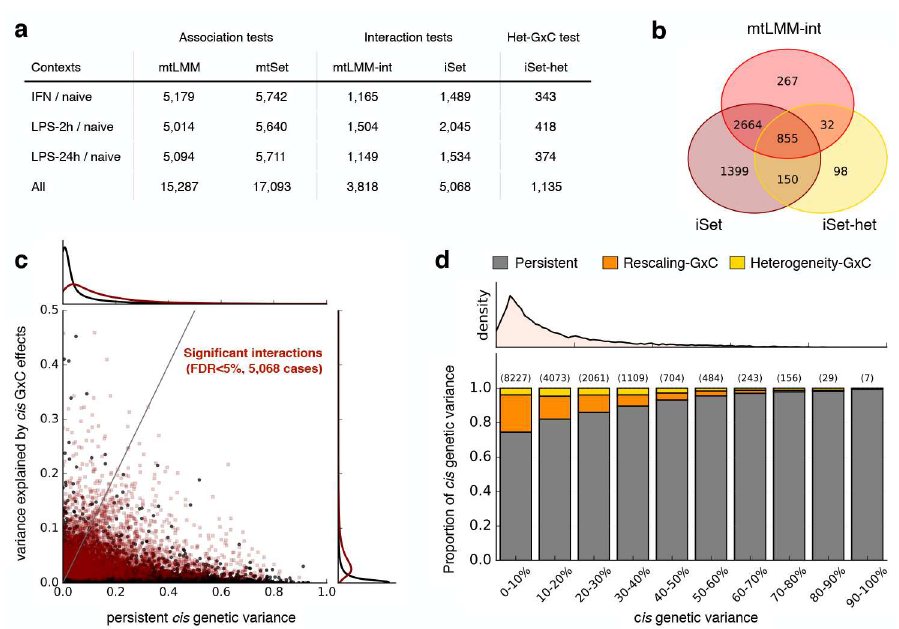
Fig 3. Analysis of stimulus-specific eQTLs in monocytes. (a) Number of probes with at least one significant cis association(Association test) or genotype-stimulus interaction (Interaction test) for alternative methods and stimulus contexts. Considered were the proposedset tests (mtSet, iSet, iSet-het) as well as single-variant multi-trait LMMs (mtLMM, mtLMM-int [10]), testing for genetic effects in cis (100kb region centeredon the transcription start site; FDR < 5%). Additionally,iSet-het was used to test for heterogeneity- GxC effects. Individual rows correspondto different stimulus contexts with “All” denotingthe total numberof significanteffects across all stimulus contexts. ( b) Venn diagram of probes and stimuli with significant interactions identifiedby alternativemethods and tests (across all stimuli). (c) Bivariate plot of the variance attributed to persistent genetic effects versus genotype-stimulus interactions for all probes and stimuli. Significant interactionsare shown in red. Density plots along the axes indicate the marginal distributionsof persistent geneticvariance (top) and variancedue to interaction effects (right), either consideringall (black) or probe/stimulus pairs with significant interactions (iSet in a , dark red). (d) Average proportions of cis genetic varianceattributableto persistent effects, rescalingeffects and heterogeneity-GxC, considering probe/ stimulus pairs with significant cis effects (5% FDR, mtSet), stratified by increasing fractions of the total cis geneticvariance.Shown on top of each bar is the numberof instances in each variance bin. The top panel shows the density of probes as a function of the total cis genetic variance.